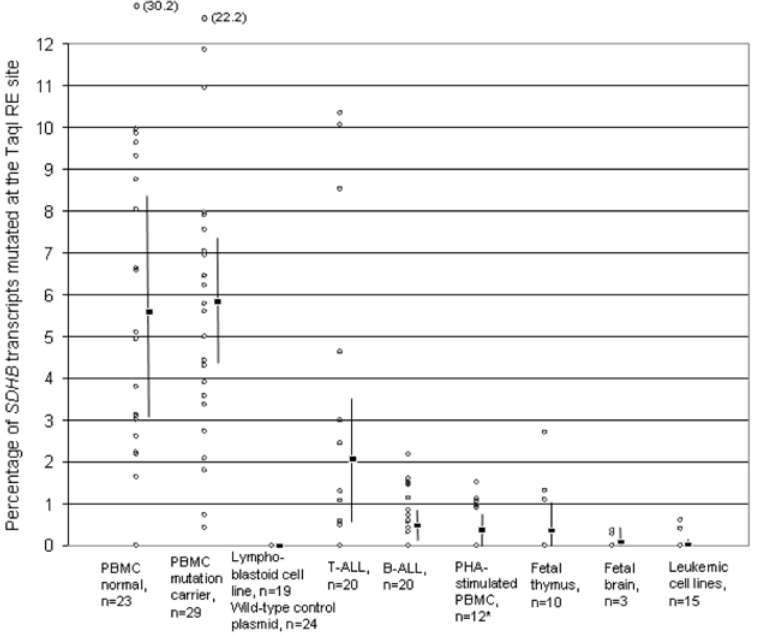
Figure 2. The steady-state fraction of mutant SDHBcDNAs resistant to TaqI RE digestion. Each circle represents a sample from a different subject (total indicated by n) except for those in the PHA stimulated PBMCs which were obtained from two normal donors, stimulated by 2.5 m g/ml and 5.0 m g/ml concentrations of PHA and tested at days 2, 5 and 8 for a total of 12 samples. The value corresponding to each circle was derived from three RT-PCR reactions. Two outlier PBMC values were shown at the top with their mutant transcript fractions in parentheses. Boxes and the vertical lines denote the means and their 95% confidence intervals of samples sets. ‘‘PBMC mutation carrier’’ group contains 5 SDHC and 24 SDHD mutation carriers. The leukemic cell lines were derived from B cells (n=3), T cells (n=9), NK cells (n=1) and monocytes